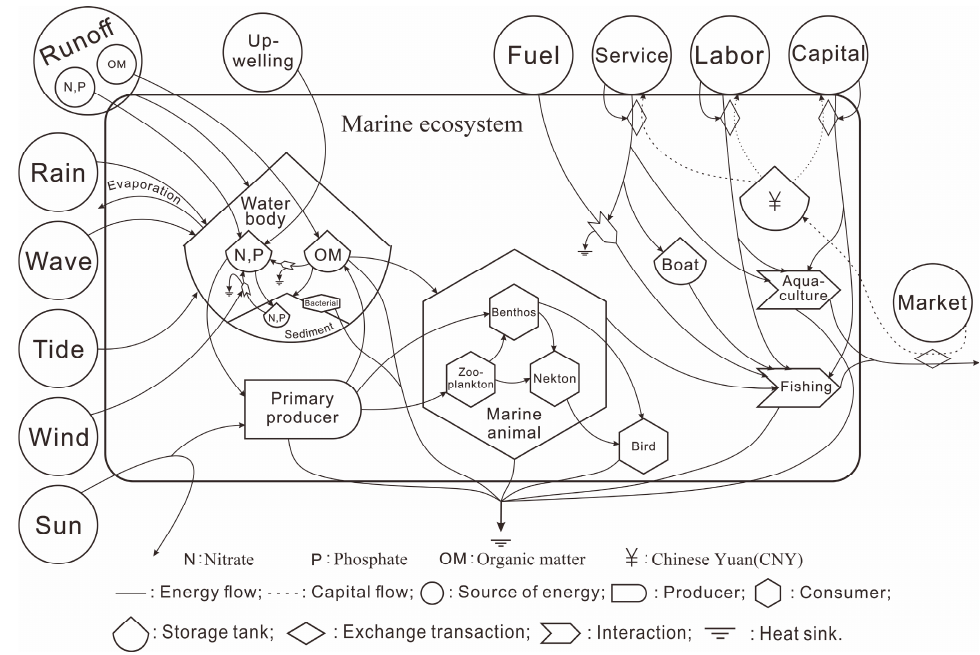
Figure 2. Model of emergy flows of Zhoushan sea area.